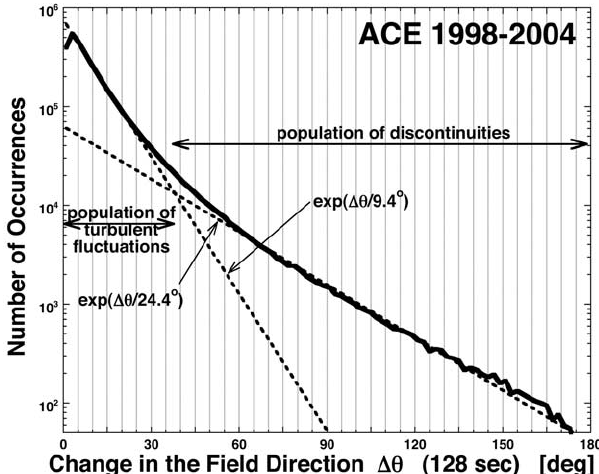
Figure 104: Measurements of angular differences of magnetic field direction on time scale of 128 s. Data set is from ACE measurements for the years 1998 – 2004. Exponential fits to two portions of the distribution are shown as dashed curves. Images reproduced by permission from Borovsky (2008), copyright by